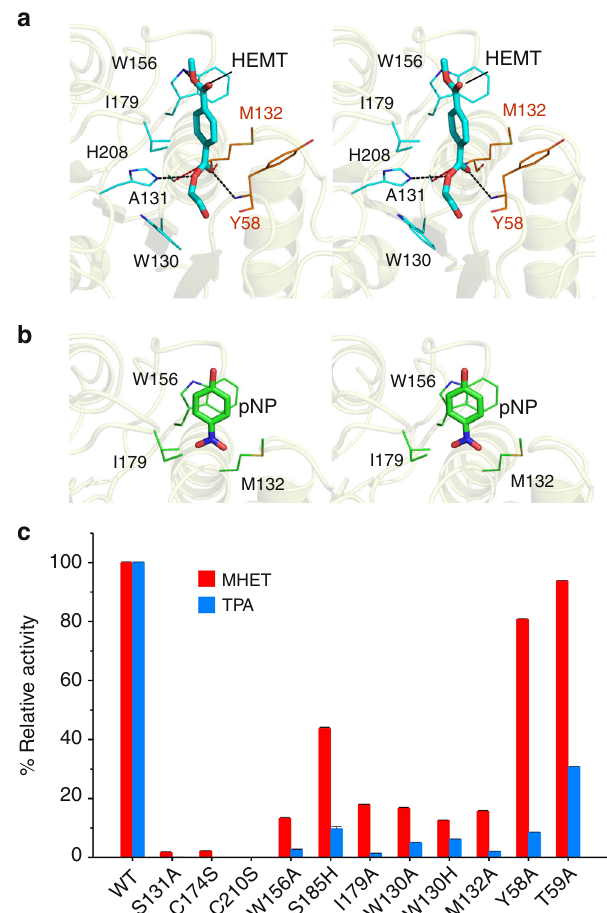
Fig. 3 Substrate-binding residues and the variants. The detailed enzyme – ligand interaction networks in a DM-HEMT and b DM-pNP are shown in stereo view. The ligands and protein residues are presented as thick and thin sticks, respectively. The oxyanion hole-forming residues are in orange. Distances < 3.5 Å are indicated with dash lines. In c , the production levels of MHET and TPA by each protein are presented as percentages of the wild type. Each measurement was conducted in triplicate, from which the average ± s.d. was